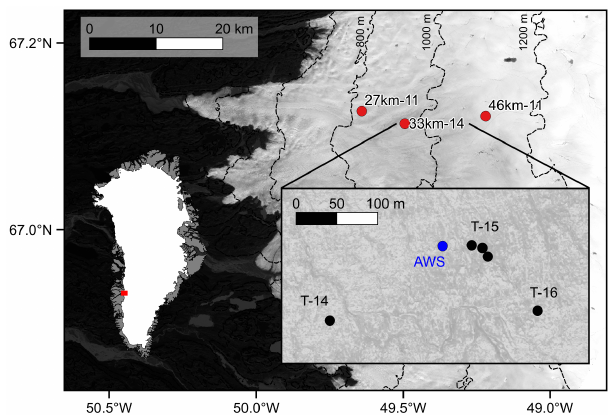
Figure 1. A site map from western Greenland with field sites (red) named by their location with respect to the outlet terminus of Isun- nguata Sermia and the two-digit year the site was first visited (i.e. 27km-11). The inset shows locations of near-surface temperature strings (black) named by the year they were installed and an auto- mated weather station (blue). Surface elevation contours are shown at 200m spacing (Howat et al.,